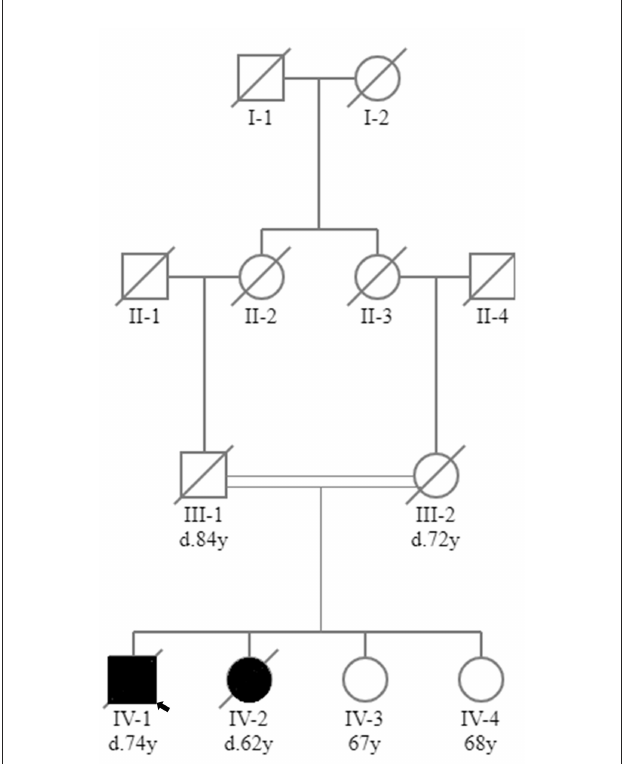
FIGURE1 Family tree. Family tree showing that the proband (IV-1) and his affected sister (IV-2) were born to consanguineous first cousin parents (III-1 and III-2). Two sisters in their 60s were unaffected (IV-3 and IV-4). Square, male; circle, female; black circle or square, clinically affected; white circle or square, clinically unaffected; line through circle or square, deceased (age of death, where known, given below circle or square as denoted by d.); double line, consanguinity; small black arrow,